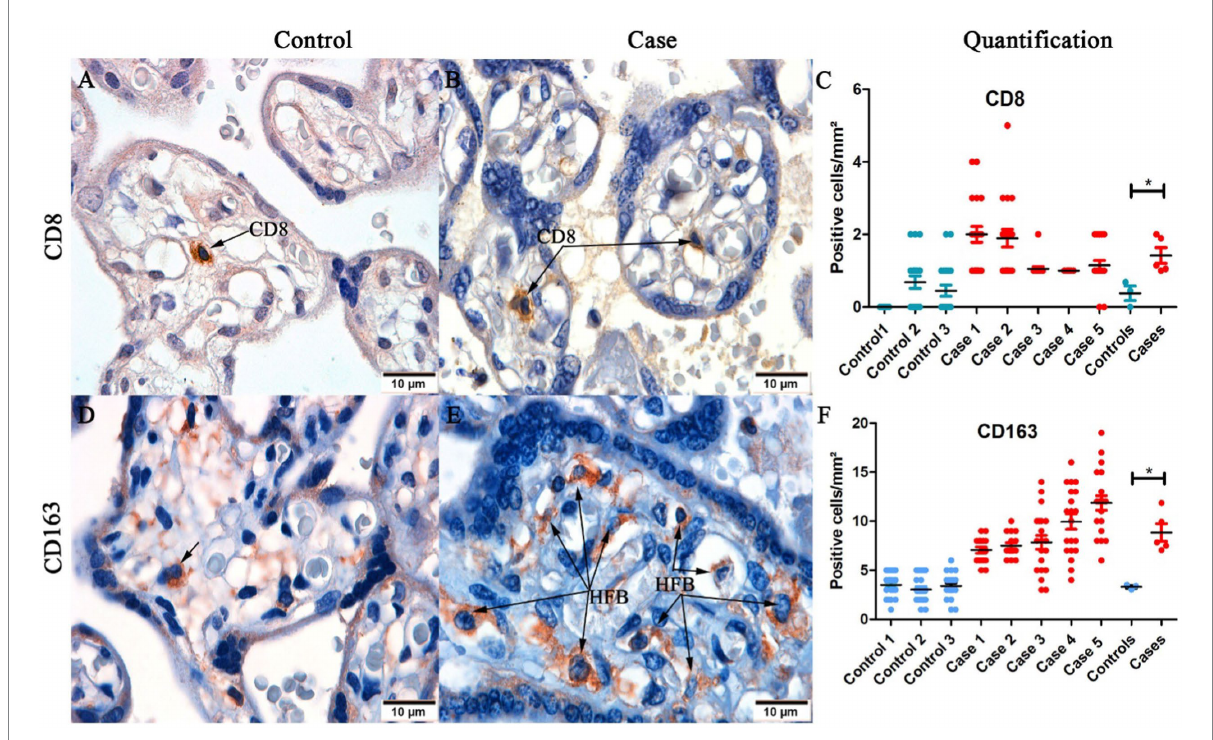
FIGURE 3 Representative images of detection of CD8 + and CD163 + cells in placental tissue. (A) Control placenta with low detection of CD8 + T cells; (B) Infected placenta with high detection of CD8+ T cells; (C) Quantification of CD8+ T cells in control and infected placentas; (D) Control placenta with low detection of CD163 + cells; (E) Infected placenta with high detection of CD163 + cells (F) Quantification and statistical analysis of CD163 + cells between control and infected placentas. (* p < 0.05). Data are represented as mean ± SDM. Magnification: 100× (A–D)